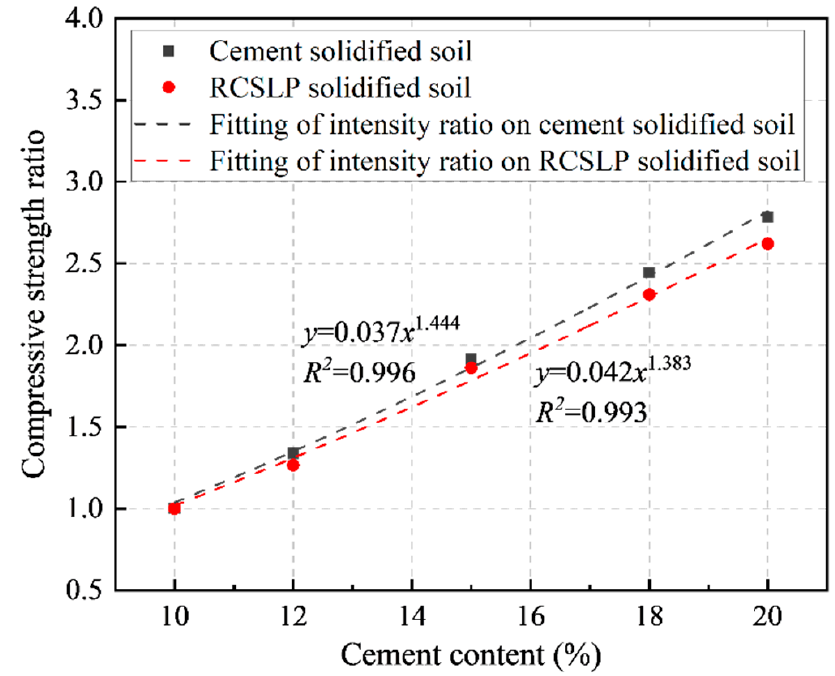
Figure 7. Compressive strength ratio variation of solidified soil with cement content.